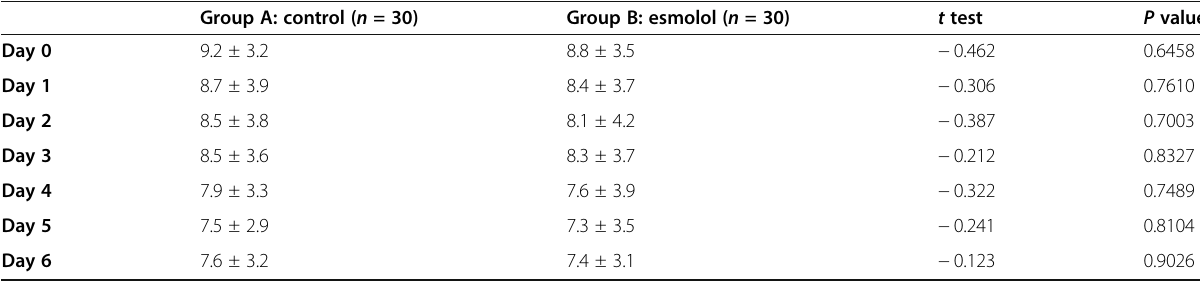
Table 4 Comparison between both groups regarding SOFA score